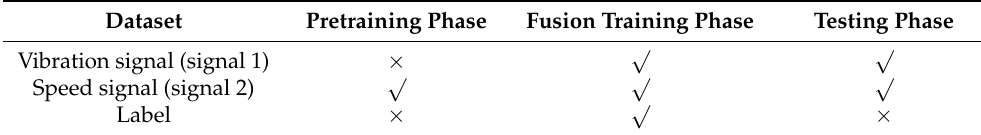
Table 1. Data usage of VSF-ST adaptive network in operating